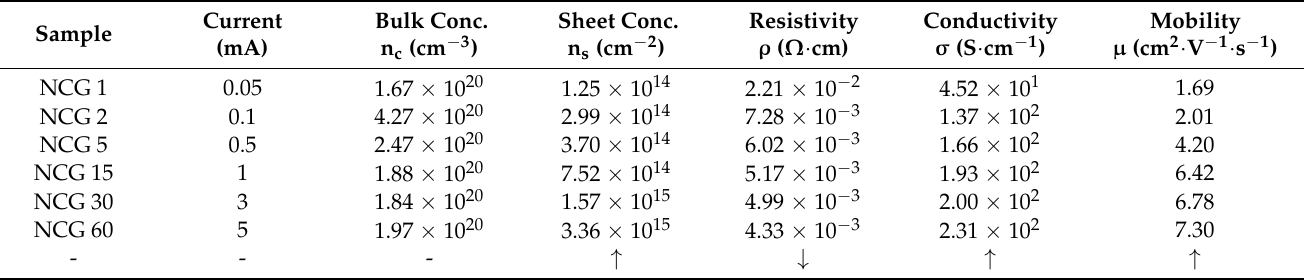
Table 3. The electrical properties of the NCG thin films resulted from Hall measurement.